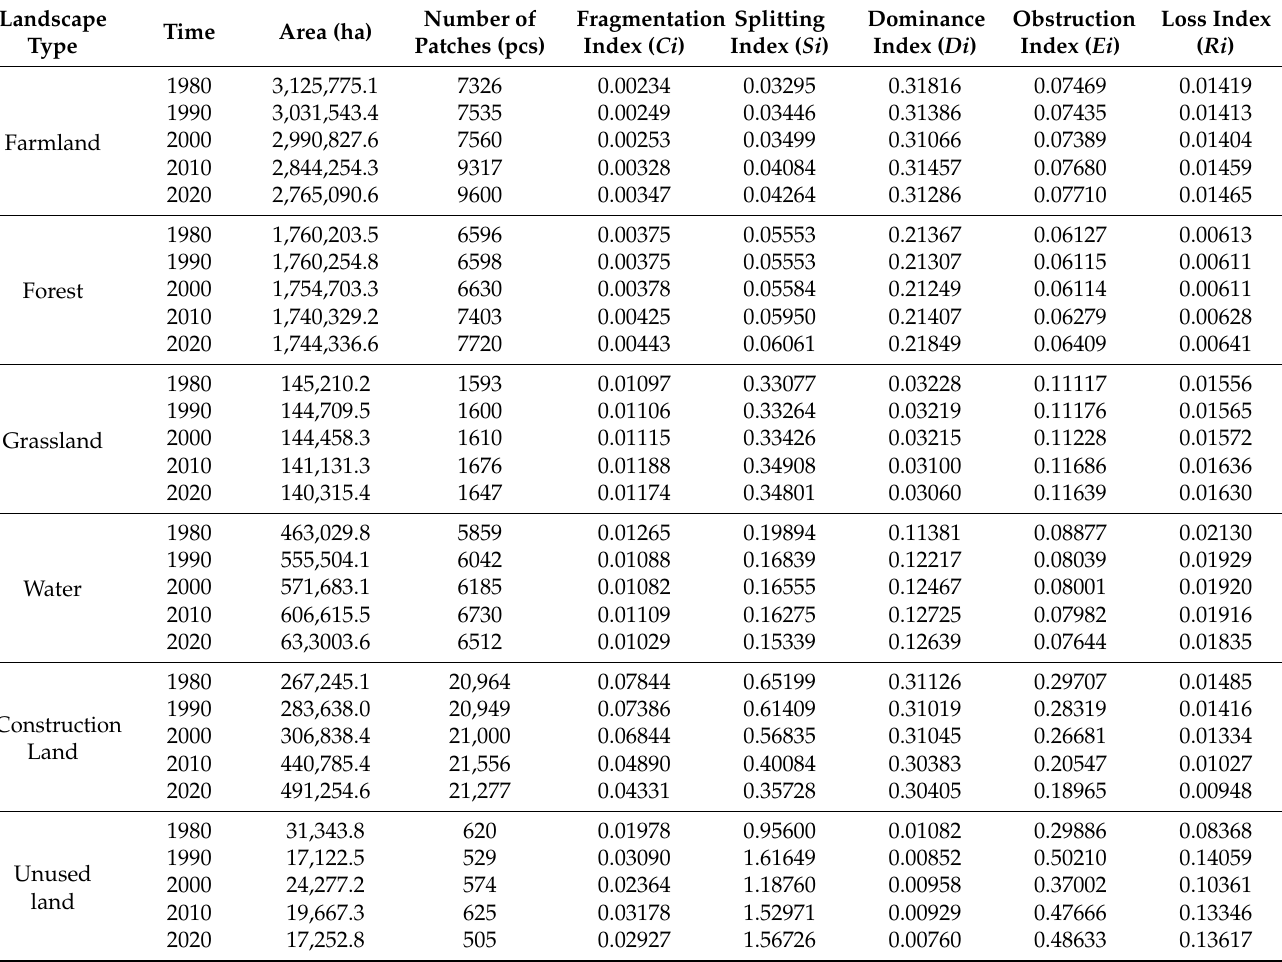
Table 3. Ecological risk index of WUA, 1980–2020.